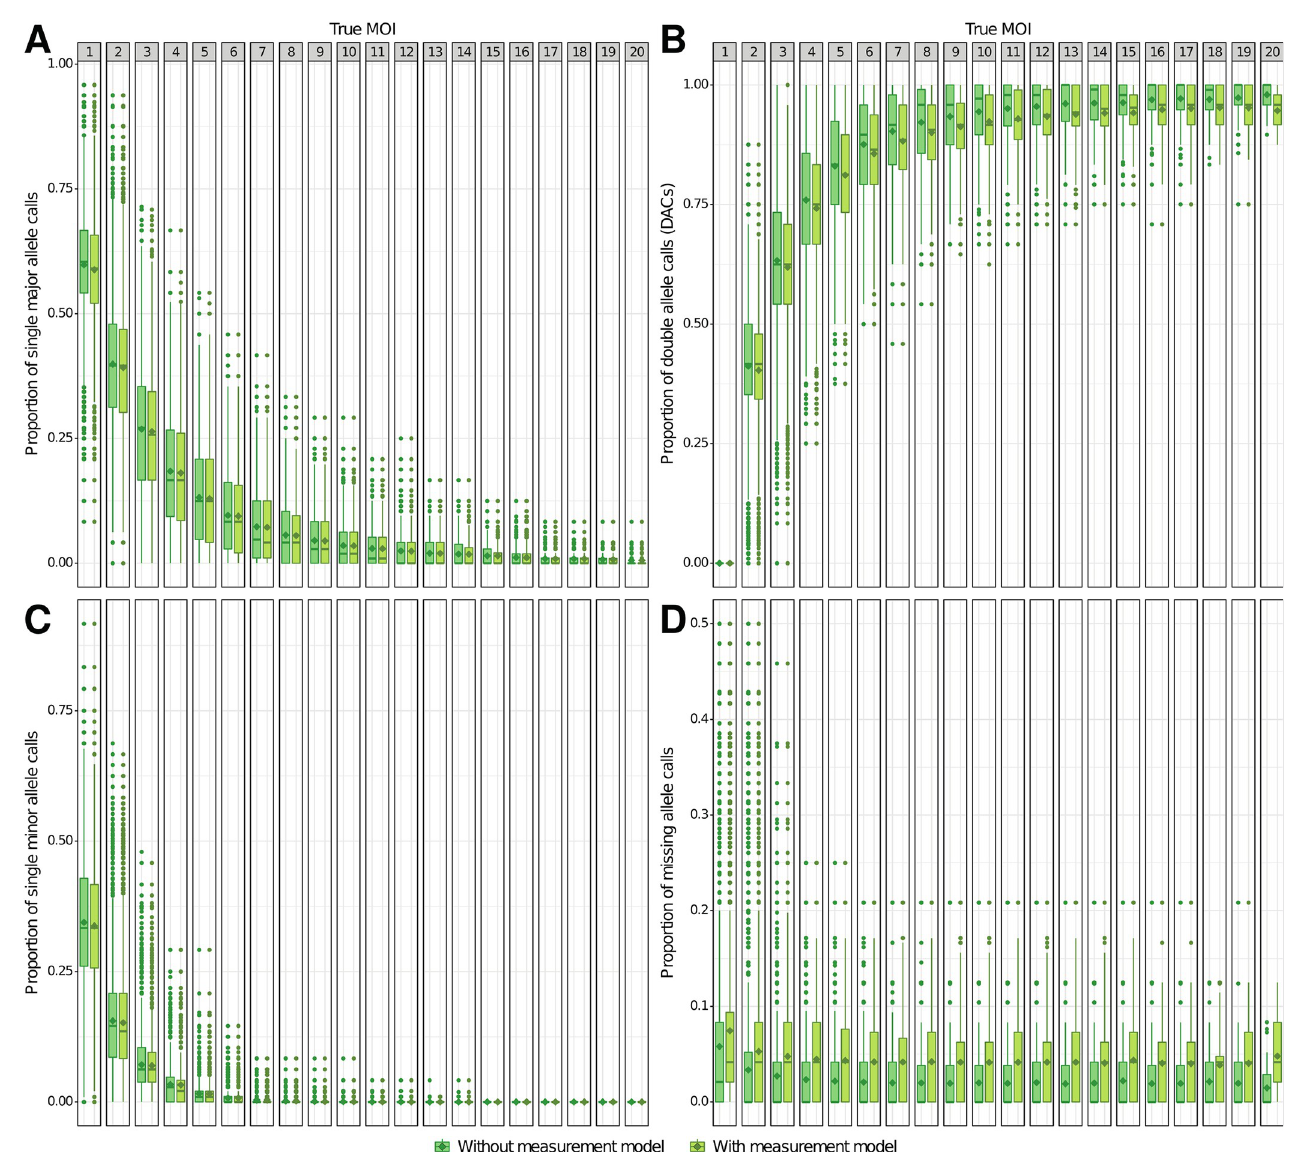
Fig 3. Proportion of SNP calls (genotypes) per host SNP haplotype. A) Single major allele calls; B) Double allele calls (DACs); C) Single minor allele calls; D) Missing allele calls. Each SNP call proportion was calculated using the low-, moderate-, and high-transmission setting simulations (S1 and S2 Tables). The column panels show the proportions for specific true MOI values. The dark and light green colors indicate the proportion of calls made without and with a measurement model, respectively (Fig 2). For each category, the horizontal central solid line represents the median, the diamond represents the mean, the box represents the interquartile range (IQR) from the 25th to 75th centiles, the whiskers indicate the most extreme data point, which is no more than 1.5 times the interquartile range from the box, and the dots show the outliers, i.e., the points beyond the